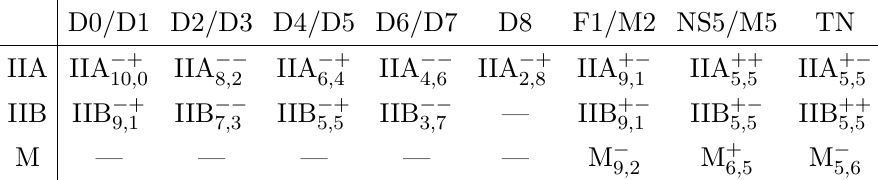
Table 3 . The exotic string theory inside the bubble surrounding negative branes of various types in string and M-theory. Here D0/D1 denotes a negative D0 (D1)-brane for type IIA (IIB) string theory, etc., and \TN" denotes a Taub-NUT geometry with negative charge (reviewed in section 8.5), which is related by T- and S-dualities to negative NS5 and D6-branes in string and M-theory,